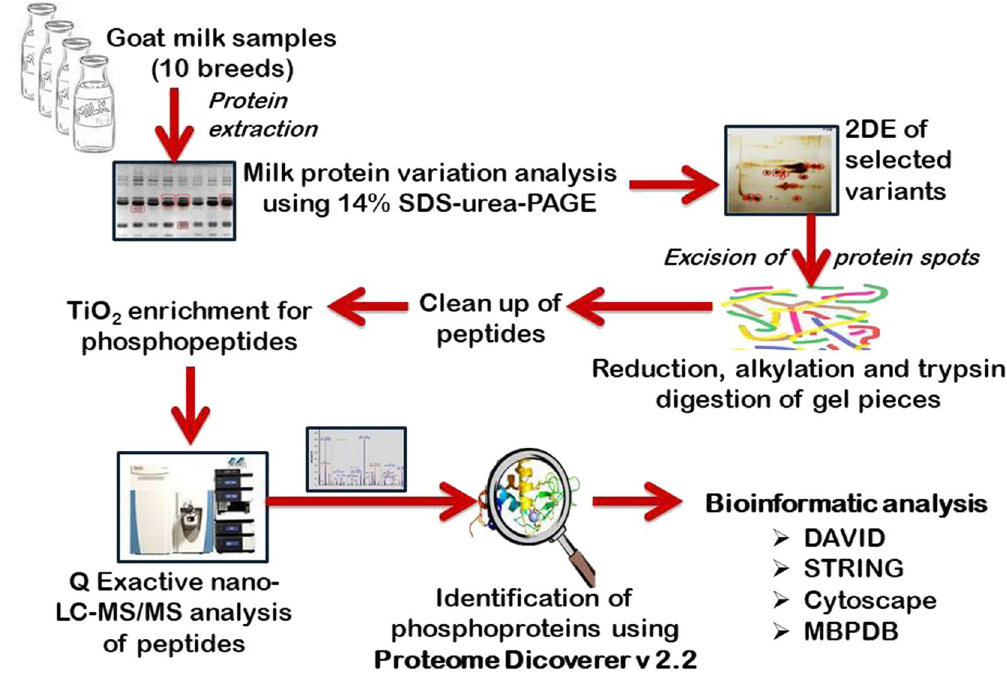
Figure 2. Flow diagram showing the methodology of PTM analysis.